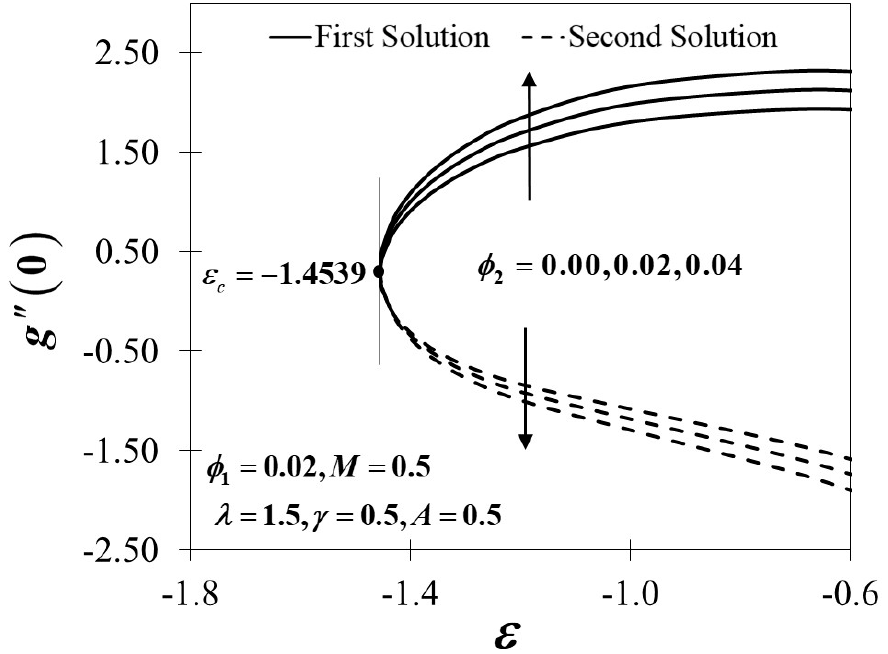
Figure 7. Variations of f (cid:48)(cid:48) ( 0 ) for di ff erent values of φ 2 .